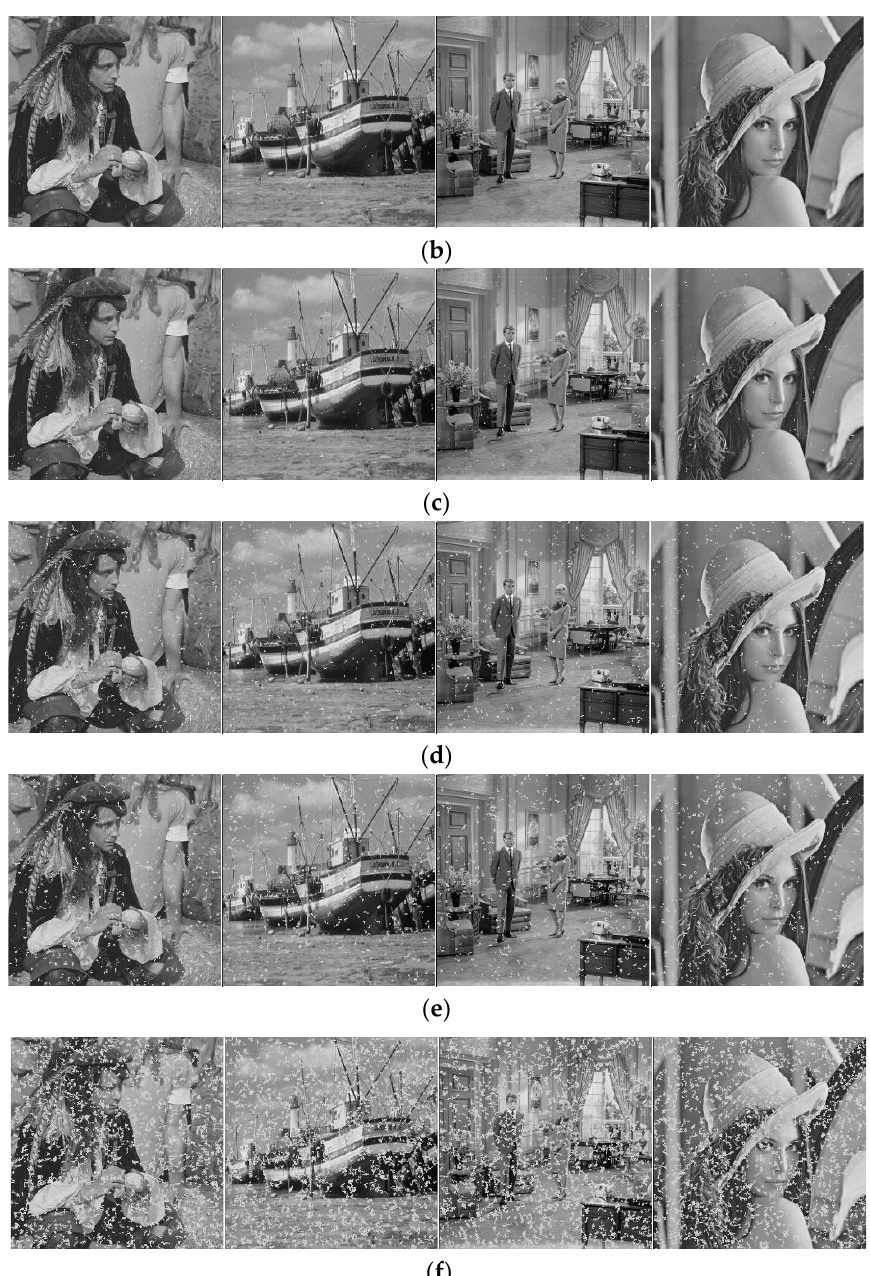
Figure 9. Prediction of natural image noise under different accumulated doses (original images from